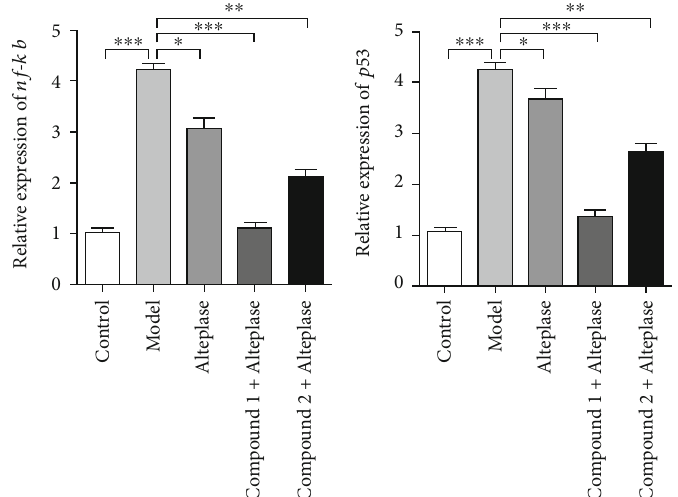
Figure 5: Obviously inhibited in fl ammatory response in the brain after compound treatment. The cerebral infarction animal model was constructed and the compound was injected for treatment at the concentration of 5 mg/kg. The real-time RT-PCR assay was conducted, and the in fl ammatory response in the brain was